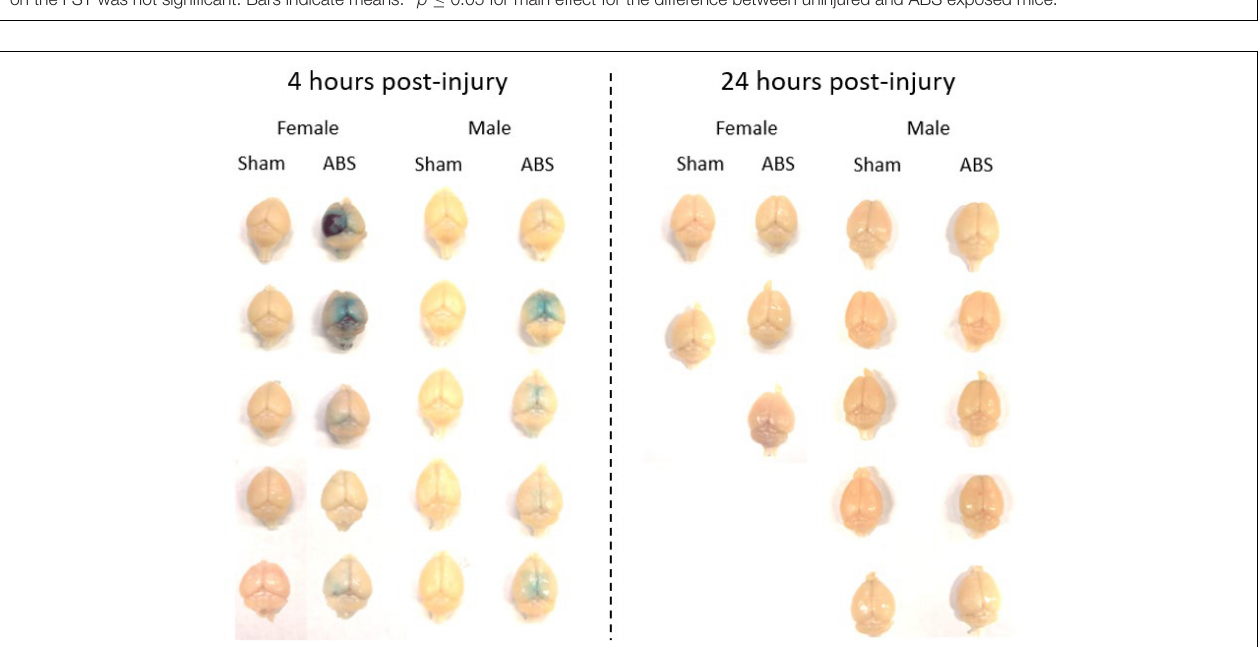
FIGURE 5 | Decreased time immobile on the TST following bTBI. (A) SPT did not show any significant difference in sucrose consumption as an effect of shock wave injury or sham treatment. (B) TST displayed a significant effect of injury with ABS mice spending less time immobile compared to sham mice. (C) The time immobile on the FST was not significant. Bars indicate means. ∗ p ≤ 0.05 for main effect for the difference between uninjured and ABS exposed mice.